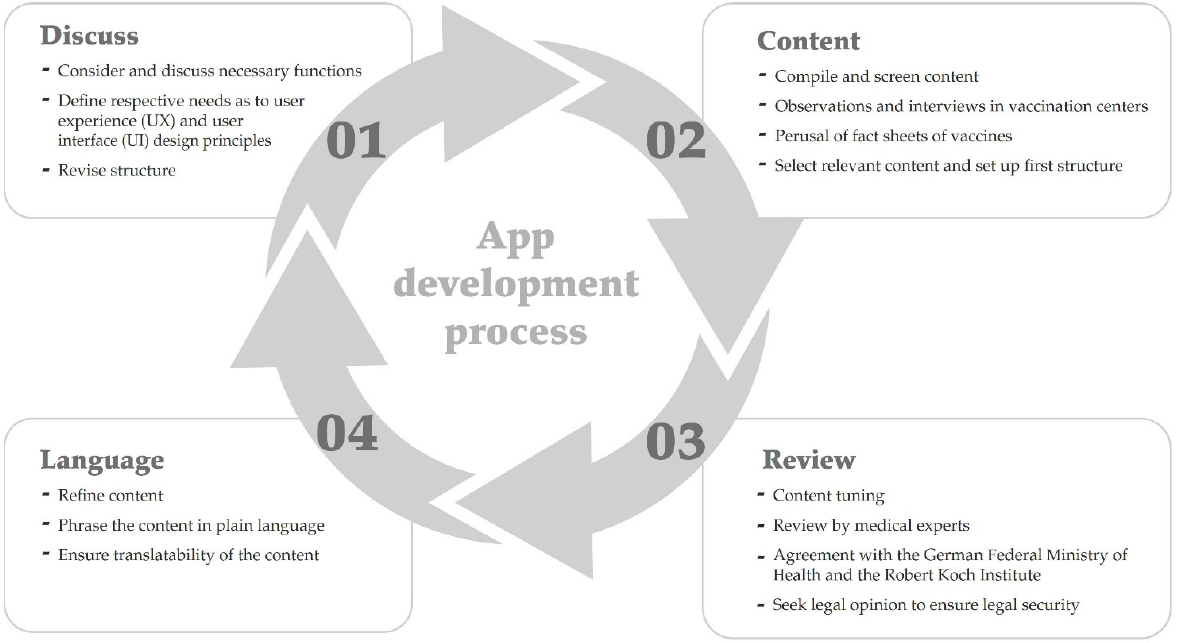
Figure 1. A graphic of the app development process. Cycles were iterative and the tasks within each cycle were performed for each update.